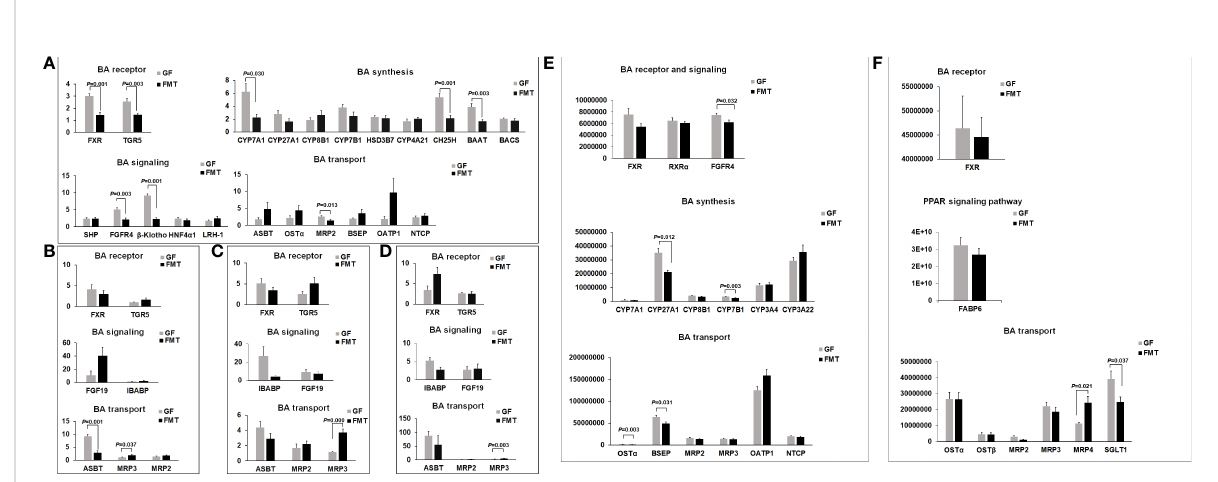
FIGURE 7 Microbiota-induced changes in gene expression of BA receptors and signaling and BA synthesis and transport. (A) Gene expression of BA receptors FXR and TGR5 and FXR target genes in the liver. Expression of genes involved in BA synthesis and BA transport in the liver. (B) Gene expression of BA receptors and their target genes in BA signaling, and expression of genes involved in BA transport in the ileum. (C) Gene expression of BA receptors and their target genes in BA signaling, and expression of genes involved in BA transport in the cecum. (D) Gene expression of BA receptors and their target genes in BA signaling and expression of genes involved in BA transport in the colon. (E) Expression of BA receptors FXR/RXR a , and expression of proteins involved in BA synthesis and transport in the liver. (F) Protein expression of BA receptor FXR, BA transport, and PPAR signaling pathway in the ileum. Protein expression is presented as the relative expression level compared with the mean expression level of the GF control group. Gene (or Protein) expression is presented as the relative expression level compared with the mean expression level of the GF control group. Mean values ± SE are plotted; n = 5 – 6 samples/group. P value indicates differences versus GF by the Welch Two-Sample t